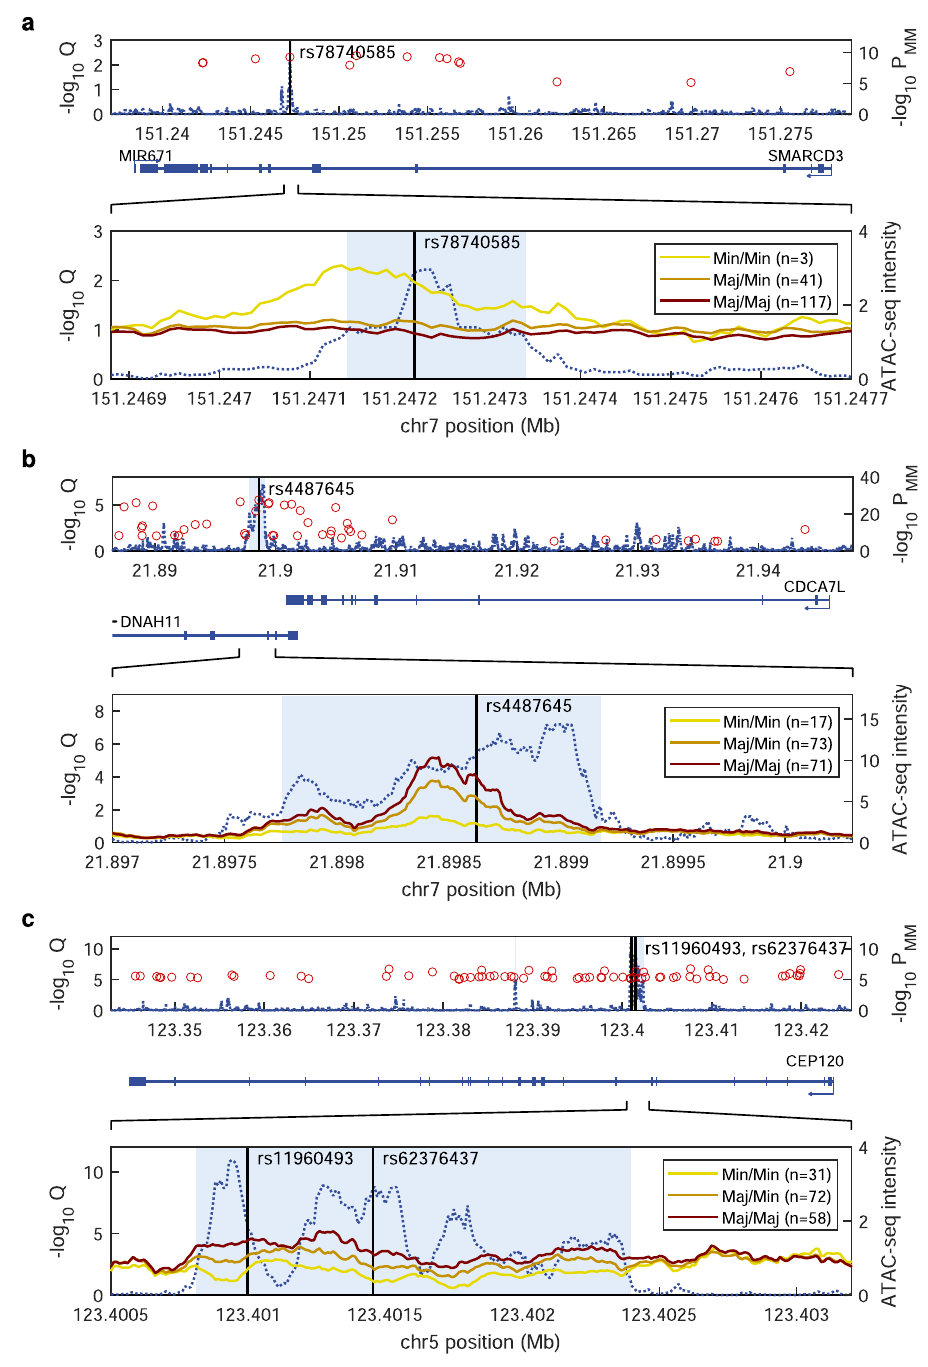
Fig. 8 Identi fi cation of co-localized caQTLs at MPRA-functional variants. We performed ATAC-seq on plasma cells from 161 MM patients and scanned the LD regions for lead variant caQTLs using two computational approaches. a In the SMARCD3 region, we detected a signi fi cant caQTL around rs78740585, with the minor allele conferring increased accessibility. Consistent with this, rs78740585[T > A] showed a positive MPRA log 2 score and the rs78740585-A risk allele creates an IRF4 site (Supplementary Fig. 4). b In the CDCA7L region, we detected a signi fi cant, 1.6kb wide caQTL around rs4487645, with the major allele conferring increased accessibility. Consistent with this, rs4487645[C> A] showed a negative MPRA log 2 score and the rs4487645-C risk allele creates an IRF4 site. c At CEP120 , we detected a signi fi cant caQTL covering rs11960493 and eight other variants, including rs62376437 which was borderline-signi fi cant in MPRA, suggesting the CEP120 association is enshrined in multiple causal variants. Dashed blue indicates a false discovery rate ( − log 10 Q value) for Pearson correlation between ATAC-seq signal intensity and lead variant genotype. Regions with lead variant-dependent accessibility called by caQTLseg are indicated in light blue. Upper panels show full regions of LD, lower panels are close-ups of highlighted regions. Red circles indicate variants that show evidence of association with MM (data from Fig. 1a; variants with P < 10 − 5 for association shown). In the lower panels, average local ATAC-seq signal intensity across individuals with different lead variant genotypes is indicated by the yellow (minor/minor), orange (minor/major), and red (major/major) lines.